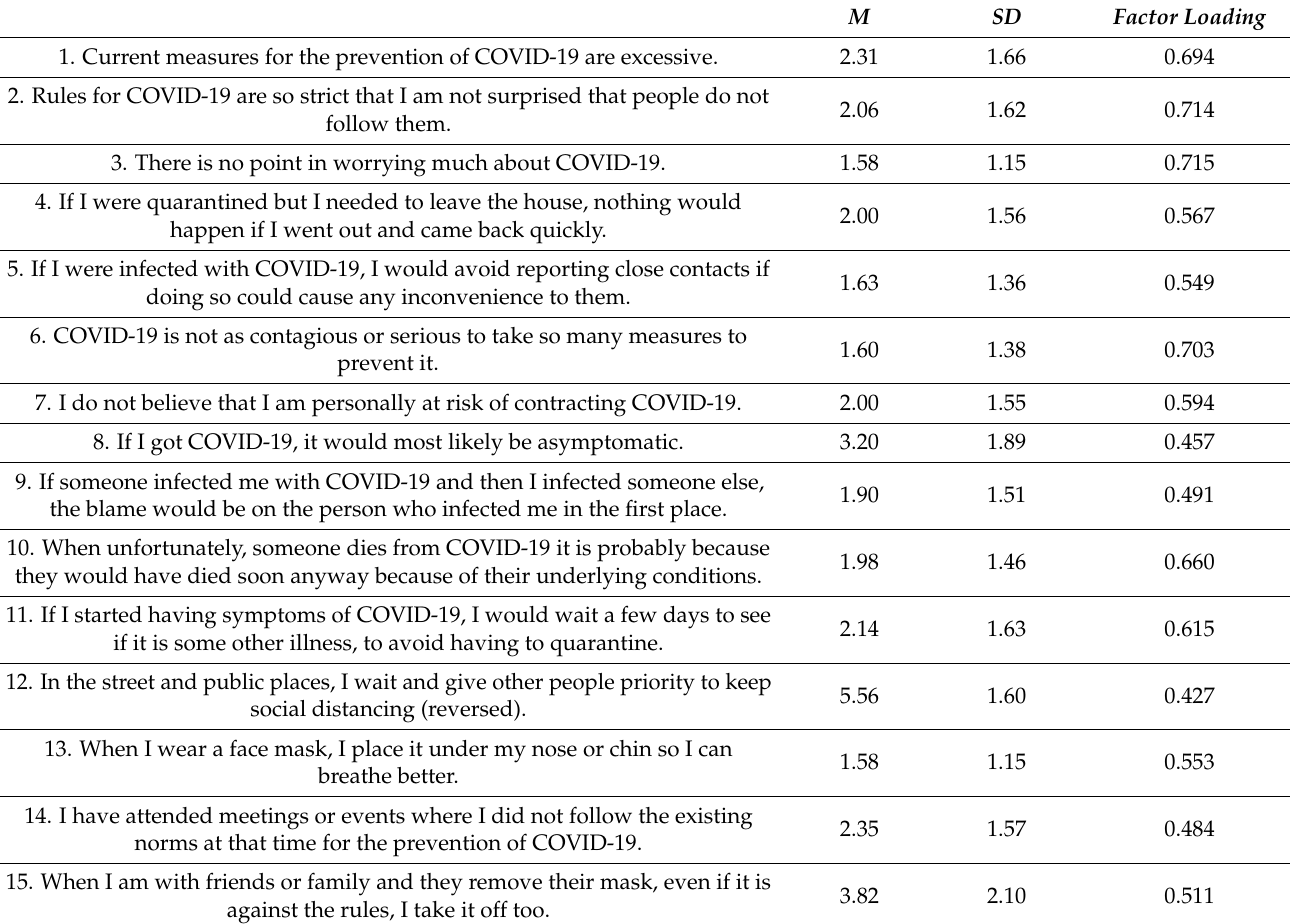
Table 3. Factor weights of attitudes and behaviors related to COVID-19 (scale